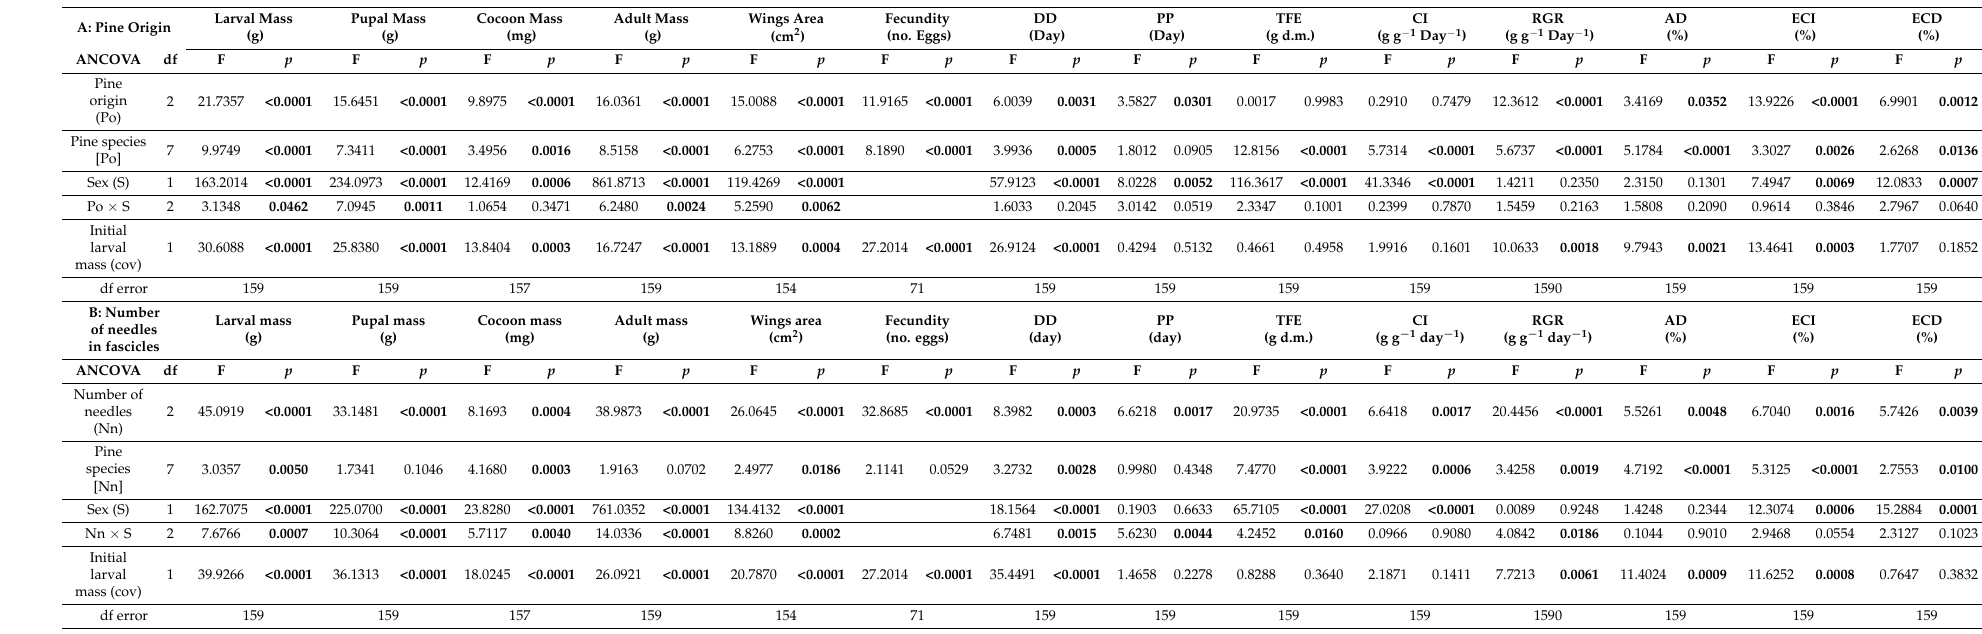
Table 2. A summary of the results of analysis of covariance (ANCOVA) for larval, pupal, cocoon, and adult masses; total wing area; fecundity; duration of development (DD); pupal period (PP); total food eaten (TFE); consumption index (CI); relative growth rate (RGR); approximate digestibility (AD); efficiency of conversion of ingested food (ECI); and efficiency with which digested food was converted to body substance (ECD) achieved by the pine-tree lappet ( Dendrolimus pini L.) larvae, which were fed with the needles of pine species from different geographical origins (A), and fed with needles of pine species with different numbers of needles in fascicles (B). A two-way analysis of covariance was used to present the effects of the pine origin (Po), pine species nested in Po, sex (S), and their interactions in part A of the table, as well as in part B to present the effects of the number of needles in fascicles (Nn), pine species nested in Nn, sex (S), and their interactions. Initial larva mass, i.e., the body mass of the larvae on the first day of the experiment, was used as a covariate to adjust initial mass differences between insects. Statistically significant differences p < 0.05 are marked in